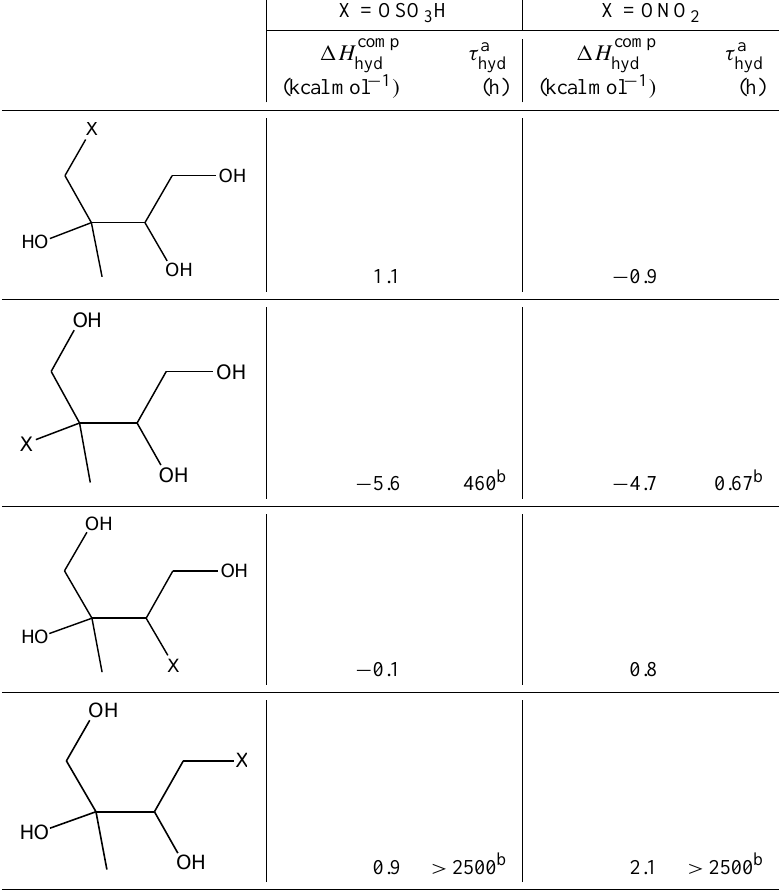
Thermodynamic and kinetic parameters for the hydrolysis of isoprene-derived 1 organonitrates and organosulfates 2